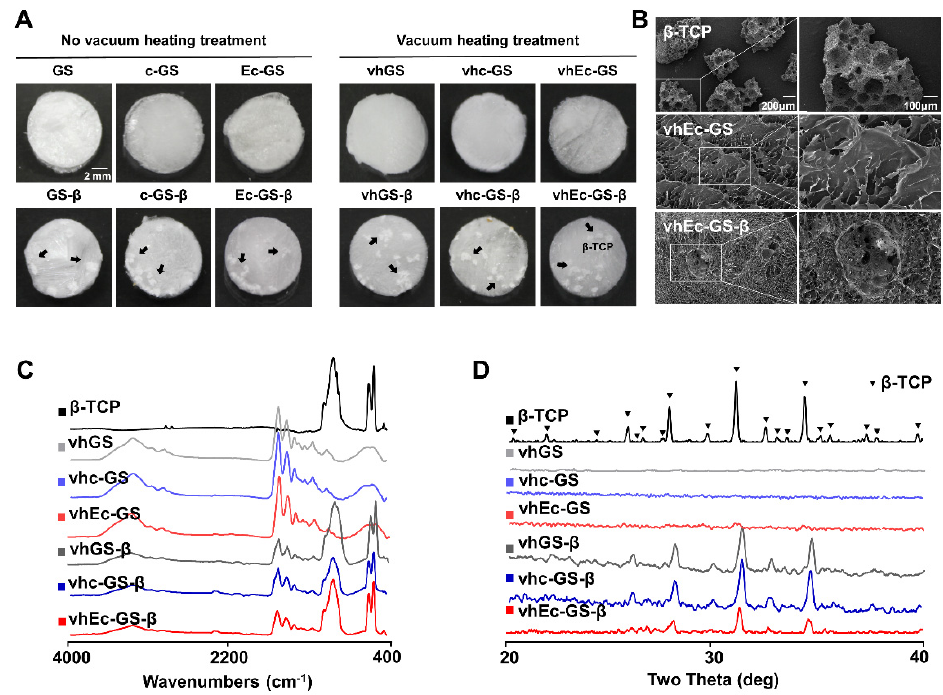
Figure 2. Characterization of sponges (precursor of hydrogels). ( A ) Macroscopic and ( B ) microscopic appearances of the sponges. Arrows: beta-tricalcium phosphate ( β -TCP) granules. ( C ) Spectra of attenuated total reflection Fourier transform infrared spectroscopy (ATR-FTIR) and ( D ) X-ray powder diffraction (XRD) on the materials.